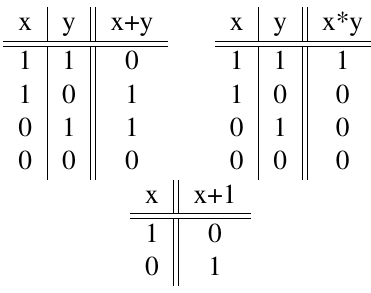
Fig. 1. Multiplication and addition in F